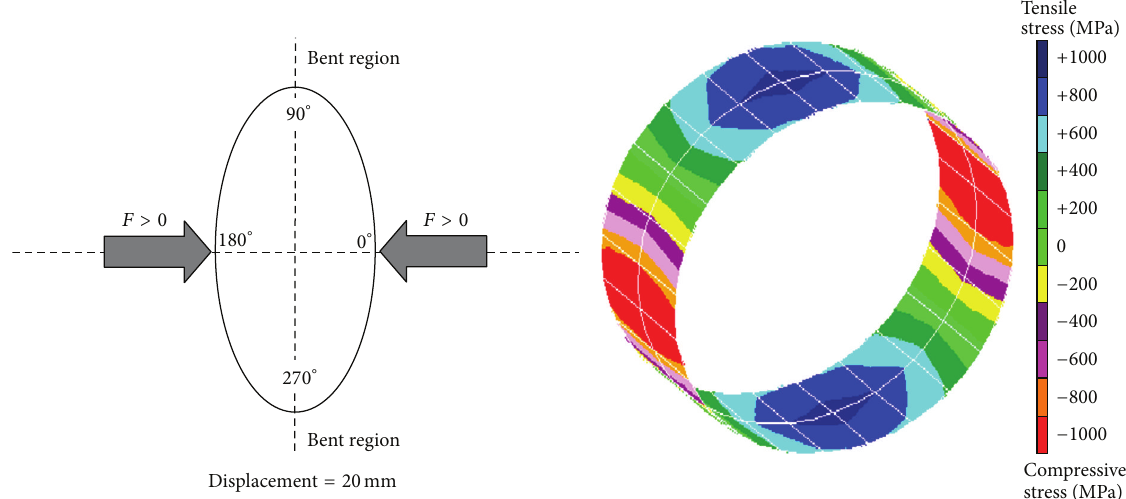
Figure 12: Stress distributions on the outer surface of the 0.5 mm thick amorphous ribbon toroidal transducer core at 20mm displacement